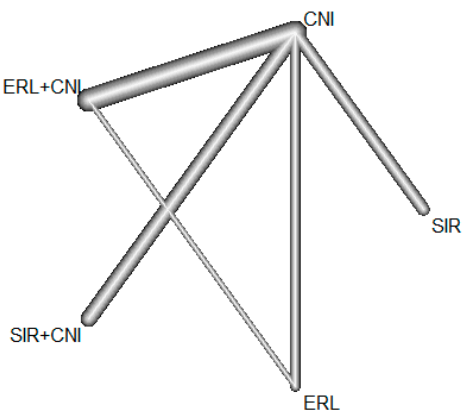
Figure 2. Geometry of the treatment network. The nodes in the graph layout correspond to the treatments, and the edges display the observed treatment comparisons. The thickness of the edges is proportional to the number of participants in trials, directly comparing the four connected treatments.